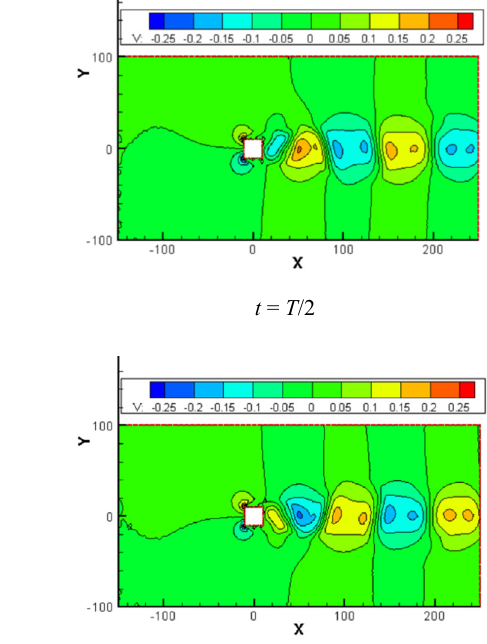
Figure 6. Time history of ( a ) U and ( b ) V velocity component of point P, location shown in Figure 5b. Since the difference of prediction of hydrostatic and non-hydrostatic SWM is not significant and flow fields of the two models are visually indistinguishable, only the simulation results of hydrostatic SWM are shown. Figures 7 and 8 show the contours of velocity components and streamlines at t = T /2 and T . A well-organized von Karman vortex street is reproduced.